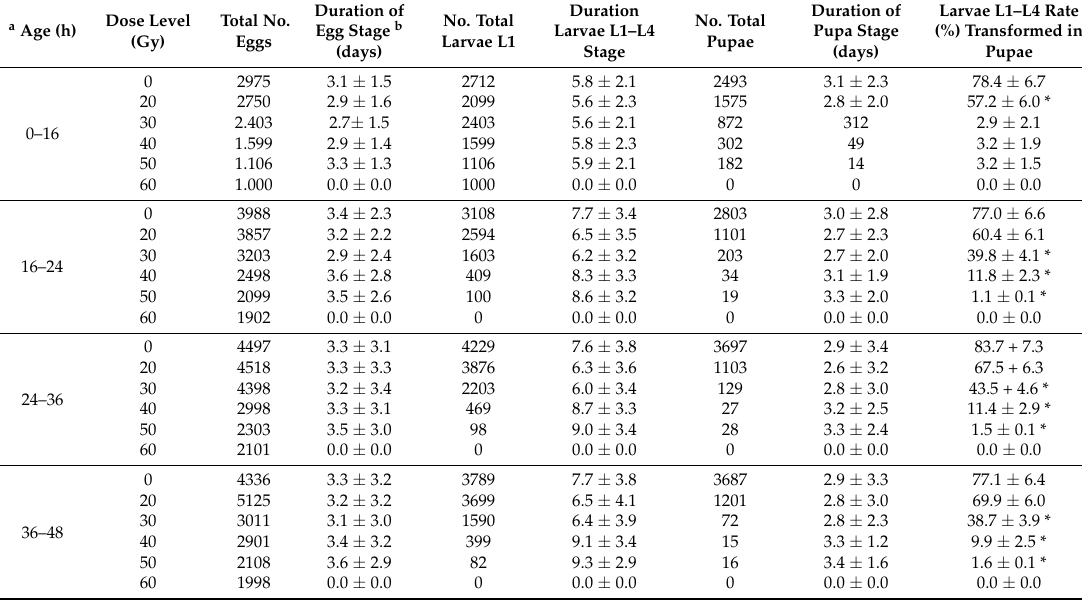
Figure 1. Percentage ( ± SD) of pupation of L1–L4 larvae from adults irradiated in the pupal phase at different ages: ( a ) 0–16 h, ( b ) 16–24 h, ( c ) 24–36 h, and ( d ) 36–48 h. Table 1. Total numbers of eggs, larvae and pupae, mean duration eggs, larvae and pupae stage, and larvae L1–L4 rates after pupae irradiation at different ages of Ae.